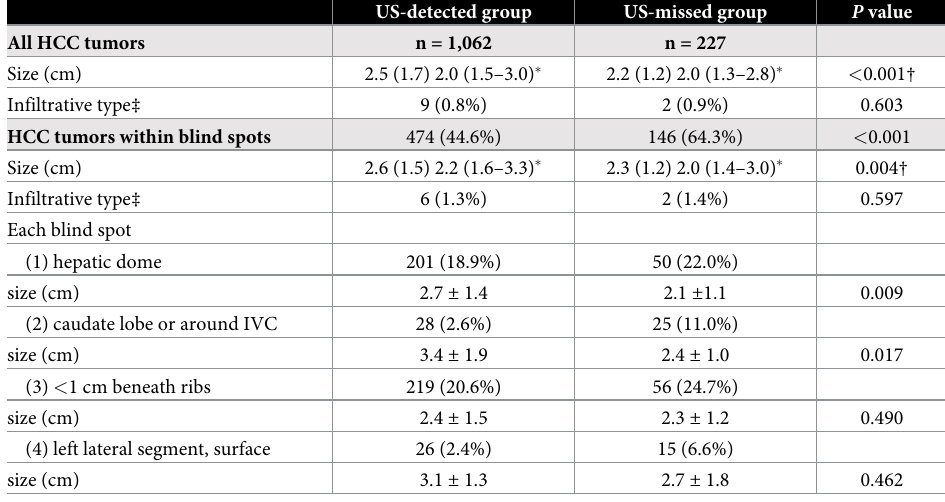
Table 2. Distribution of hepatocellular carcinoma tumors by characteristic and blind spot location on